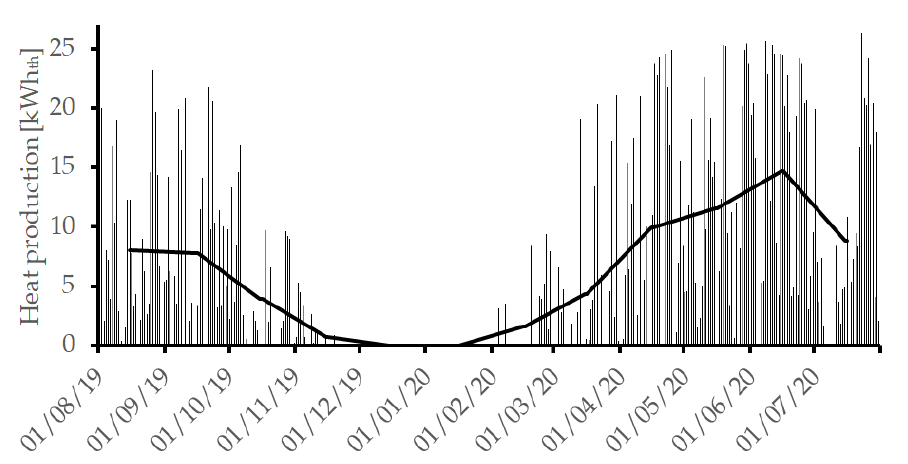
Figure 6. Solar heat